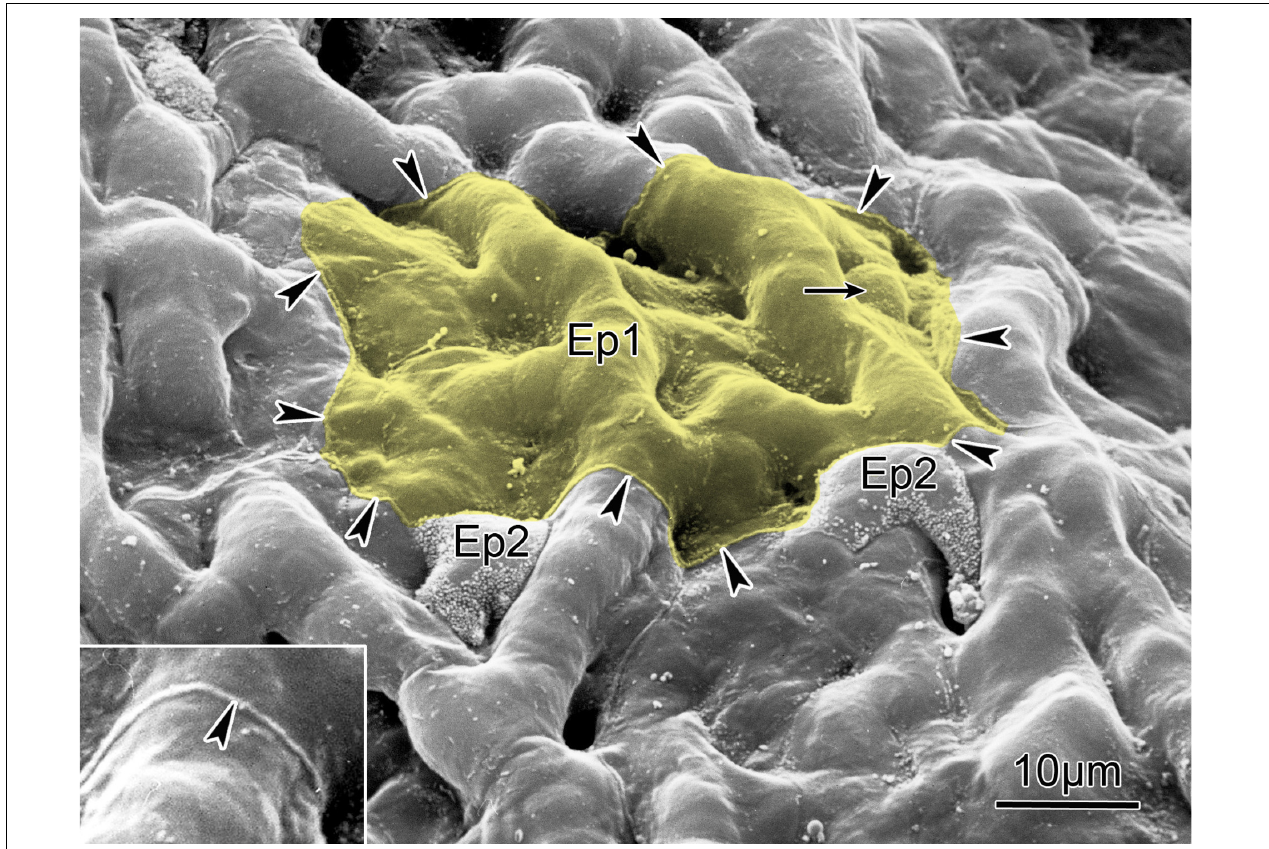
FIGURE 2 | Scanning electron micrograph of the alveolar surface of a human lung showing protruding capillaries and two type II cells (Ep2) sitting in niches and characterized by a rim of microvilli. Small arrow points to cell body of a type I cell (Ep1) that covers several capillary meshes (yellow); the boundary of its cytoplasmic leaflet is marked by arrowheads outlining a small lip of the cell junction between adjoining cells (inset, compare Figure 1B ). The surface area covered by this cytoplasmic leaflet is 1,300 mm 2 . Scale bar = 10 µ m (from Weibel, 2015); reprinted with permission of the American Thoracic Society.